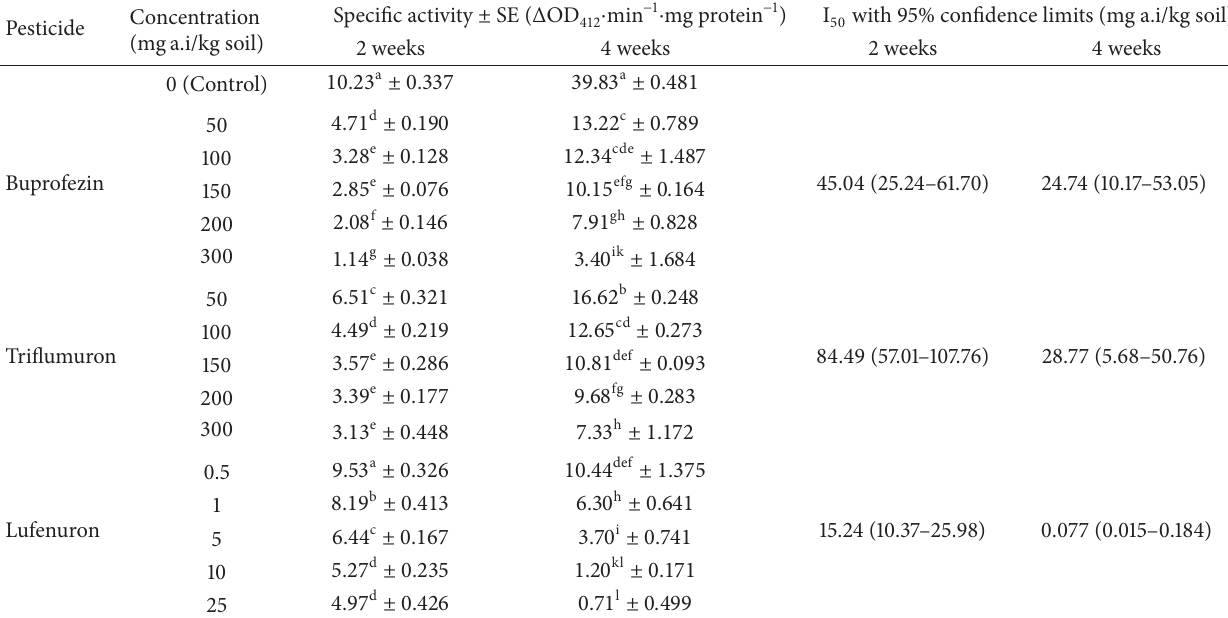
Table 3: Mean AChE specific activities ± SE measured in mature earthworms ( A. caliginosa ) after exposure to different concentrations of buprofezin, triflumuron, and lufenuron for one, two, and four weeks. Pesticide